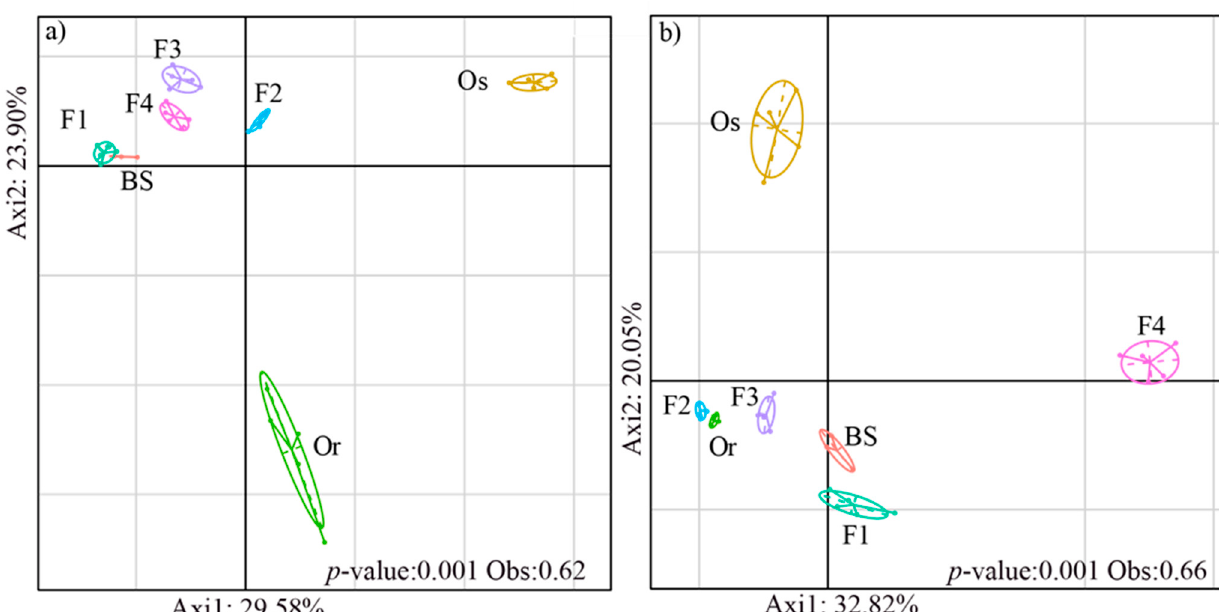
Figure 2. Between-class analysis (BCA) of ( a ) bacterial and ( b ) fungal communities in bulk soil (BS) and the rhizospheres of the female parent Oryza rufipogon (Or) wild rice; male parent Oryza sativa (Os) cultivated rice; hybrid generation (F1); and the generations F2, F3 and F4 obtained by self-crossing. Each rice generation is represented by a circle, the size of each circle represents the 95% confidence interval.